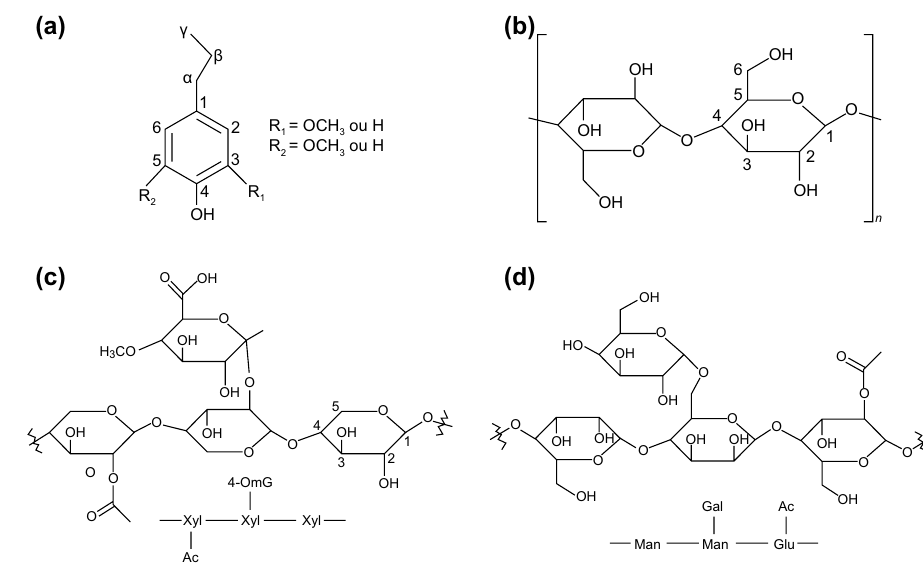
Fig. 3 Basic constituents of biomass, a lignin, b cellulose, c xylans, and d glucomannan, respectively